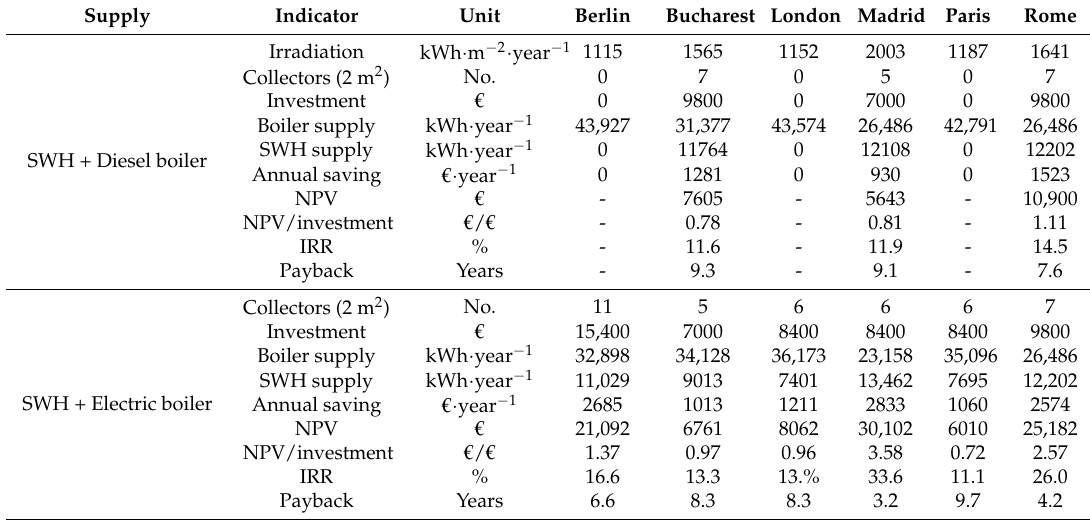
Table 2. Profitability indicators of the installation in the building of 10 homes. NPV: net present value; and IRR: internal rate of return.